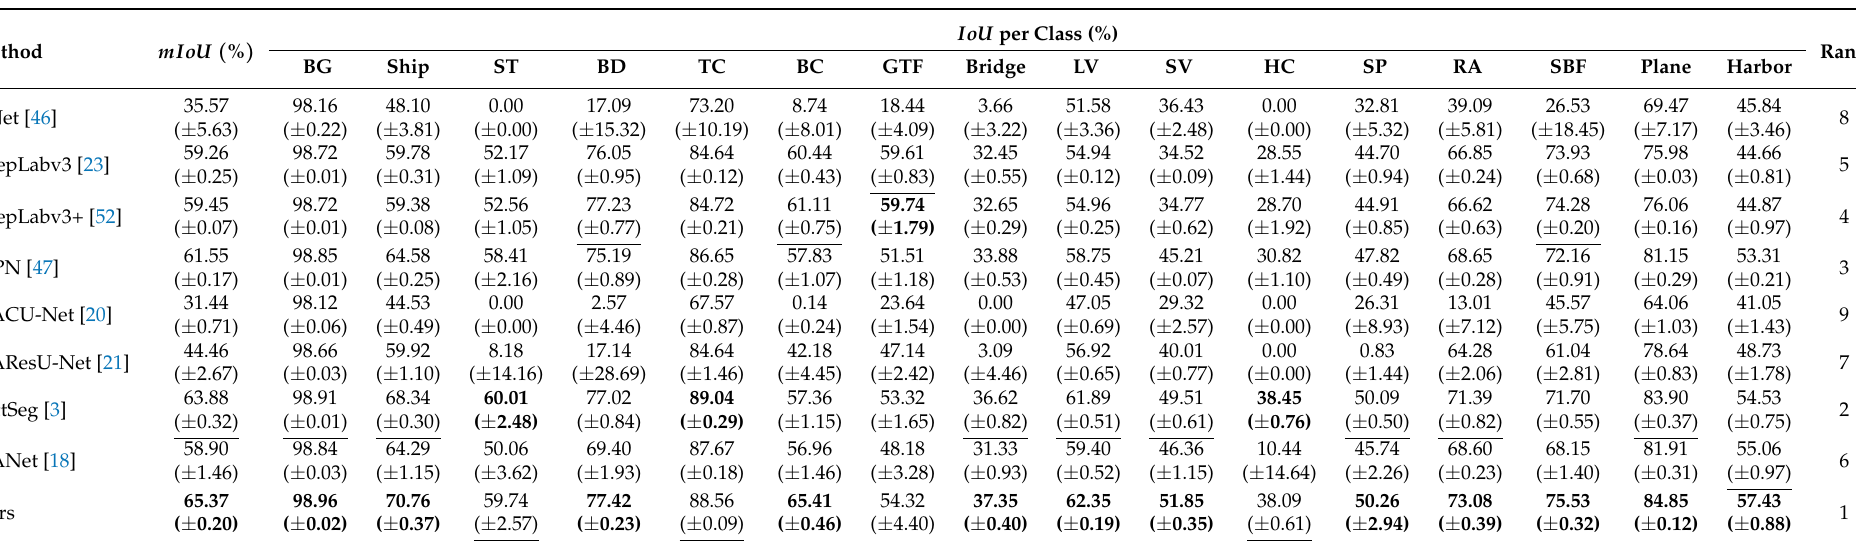
Table 2. The quantitative results of PGNet and SOTA methods on the iSAID dataset. The best results are highlighted in bold , and the second-best is marked in underline. Result form: mean ± standard